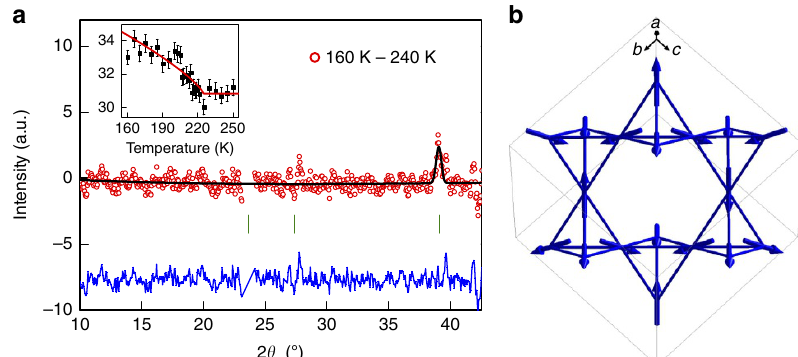
Figure 1 | Magnetic structure determination of Cd 2 Os 2 O 7 with neutron diffraction. ( a ) NPD measurements on 114 Cd 2 Os 2 O 7 . The 114 Cd isotope was used to overcome the significant neutron absorption of Cd. The data (red circle) show the difference between measurements taken at 240 and 160K and was fit with an all-in/all-out magnetic structural model (black line). The blue line is the difference between the measurement and magnetic model. (Inset) The (220) magnetic reflection intensity, 2 y ¼ 39.1 (cid:2) , shows magnetic ordering occurs at T N ¼ 225K. The error on the data represents the square root of the measured counts. The red line is a guide to the eye derived from a least squares fit to a power law. ( b ) The spins (blue arrows) all point in or out of the centre of the tetrahedron forming the all-in/all-out magnetic structure in Cd 2 Os 2 O 7 . The bonds between Os ions forming the tetrahedra are shown as solid lines.